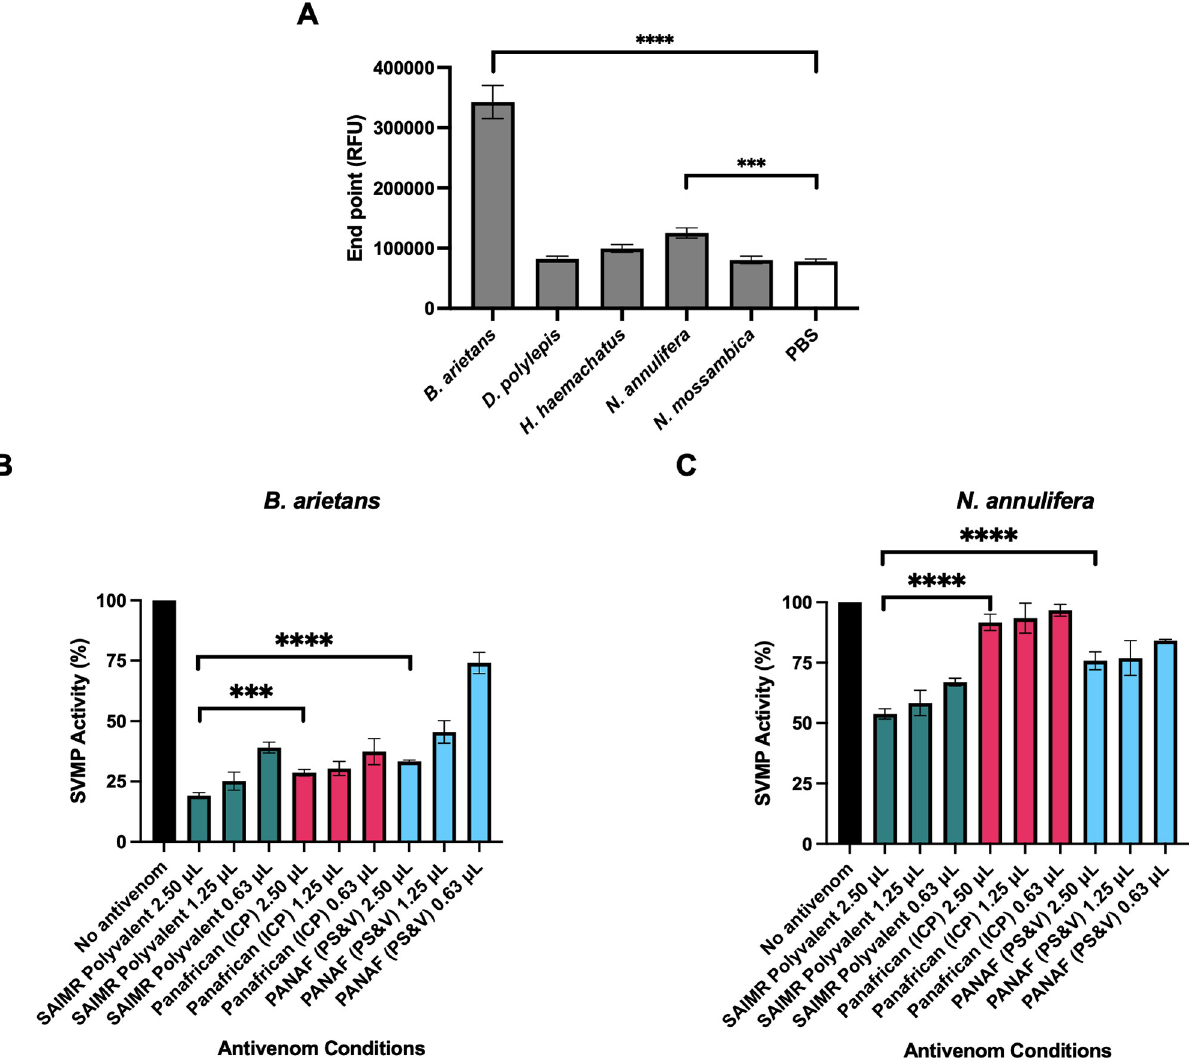
Fig 5. SVMP activity of Eswatini venoms and their neutralisation by three antivenoms. ��� indicates p < 0.001, ���� indicates p < 0.0001 by one- way ANOVA. A: SVMP activity of B . arietans , D . polylepis , H . haemachatus , N . annulifera and N . mossambica in comparison to PBS control. Data show the mean of four replicates and error bars represent standard deviation. Neutralisation of (B) B . arietans and (C) N . annulifera SVMP activity by the three antivenoms SAIMR Polyvalent (SAVP), Panafrican (ICP) and PANAF (PS&V) at different doses, in comparison to a no antivenom control (venom only) showing 100% activity. Data show the mean of four replicates and error bars represent standard deviation.